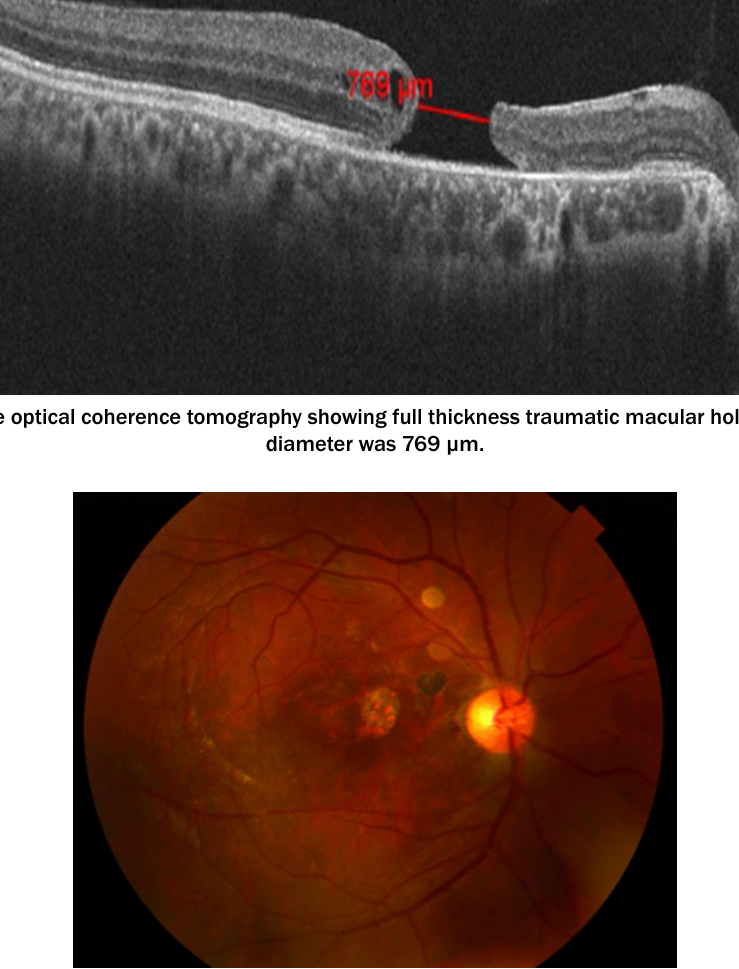
Figure 2: Fundus photo 6 months postoperative showing closed macular